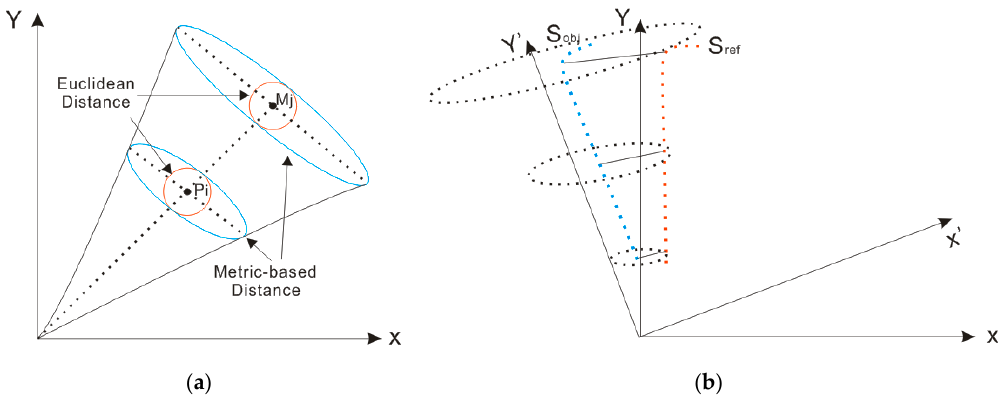
Figure 3. ( a ) Iso-distance curves: the blue curve is from the metric-based distance, and the red curve is from the Euclidean distance; ( b ) associations between scans with large scans that are built by the metric-based distance.